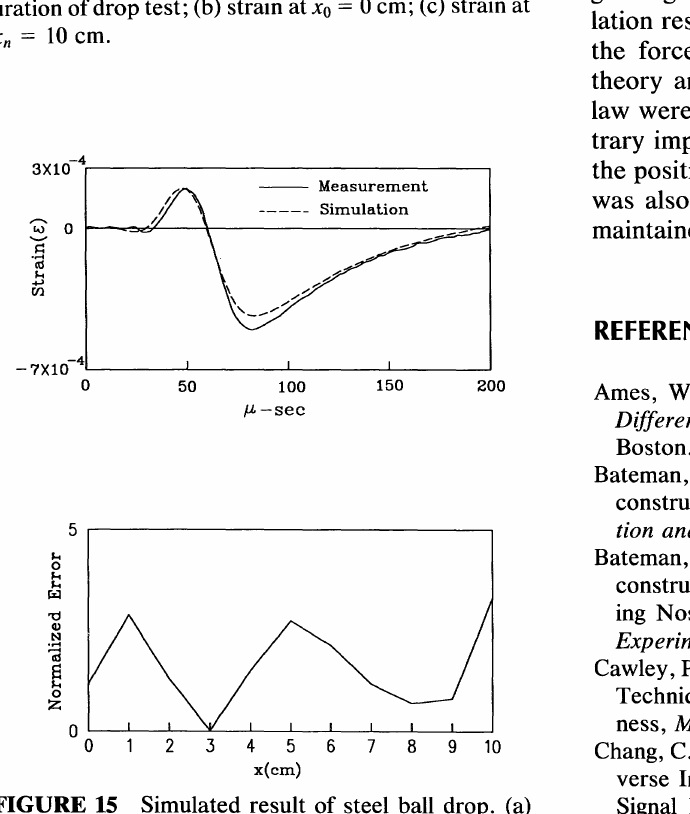
FIGURE 15 Simulated result of steel ball drop. (a) Strain history at xn = 10 cm; (b) error